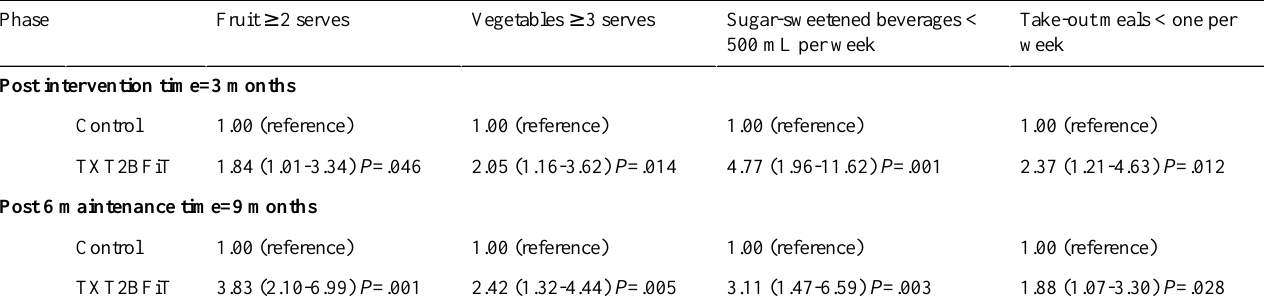
Table 4. Odds ratios (95% confidence intervals) of meeting recommendations for TXT2BFiT intervention versus control post-intervention (3 months) and post-maintenance (9 months) adjusted for practice and sex.